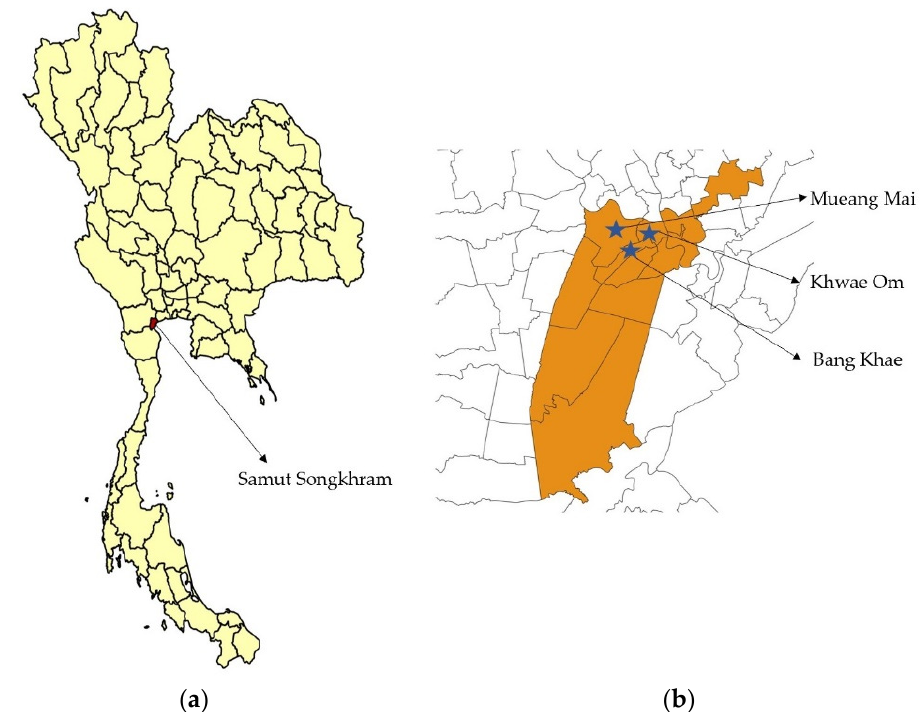
Figure 1. ( a ) The location of Samut Songkhram Province, Thailand. ( b ) The map of Amphawa District. The blue stars mark three subdistricts from which the participants were recruited.